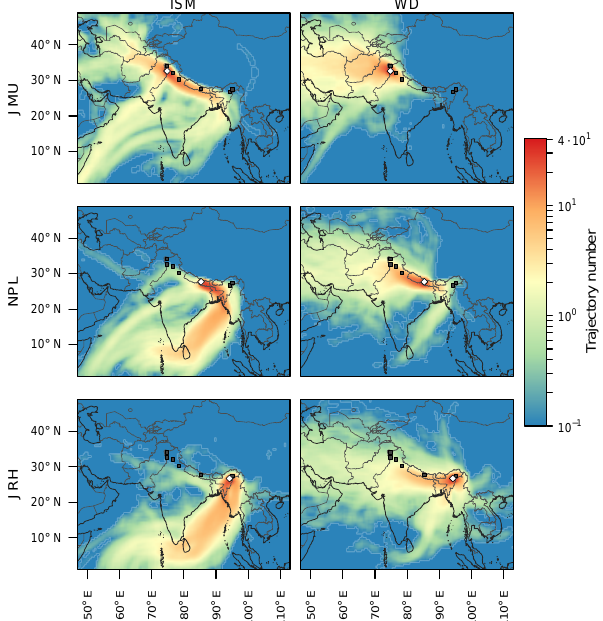
Figure 9. Footprint maps of air masses arriving at three stations: Jammu (JMU), Kathmandu (NPL) and Jorhat (JRH) representing the respective western, central and eastern parts of the east–west study transect along southern foothills of the Himalayas (a, b, c) . Separate maps were prepared for the Indian summer monsoon (ISM) and western disturbances (WD) periods. Daily trajectories for the period 2009–2011 were reconstructed using the HYSPLIT modelling framework (see text for details). International boundaries are only indicative and as provided by the software. The colour scale indicates the focally averaged number of trajectories passing through a grid